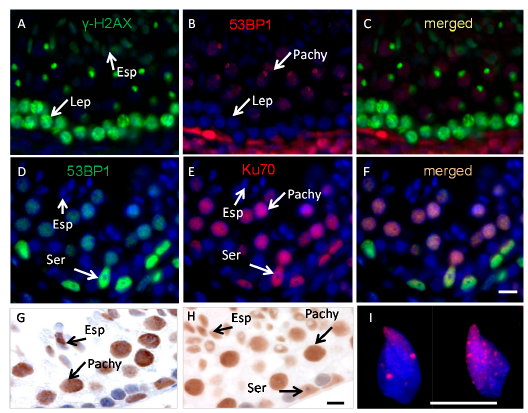
Figure 1. Localization of the phosphorylated-H2 variant ( γ -H2AX, green) ( A ), 53 binding protein1 (53BP1, red, B , C and green, D ), Ku70 (red, E , F ), X-ray repair cross-complementing protein 1 (PARP1) ( G ) and X-ray repair cross-complementing protein1 (XRCC1) ( H ) in non-irradiated testis sections; ( I ) Meiotic spreads of elongated spermatids from RAD54/RAD54B deficient mice stained for γ -H2AX and counterstained with DAPI (blue). Elongated spermatids (Esp), Leptotene (Lep), Pachytene (Pachy), Sertoli (Ser). Scale bars: 10 µm.